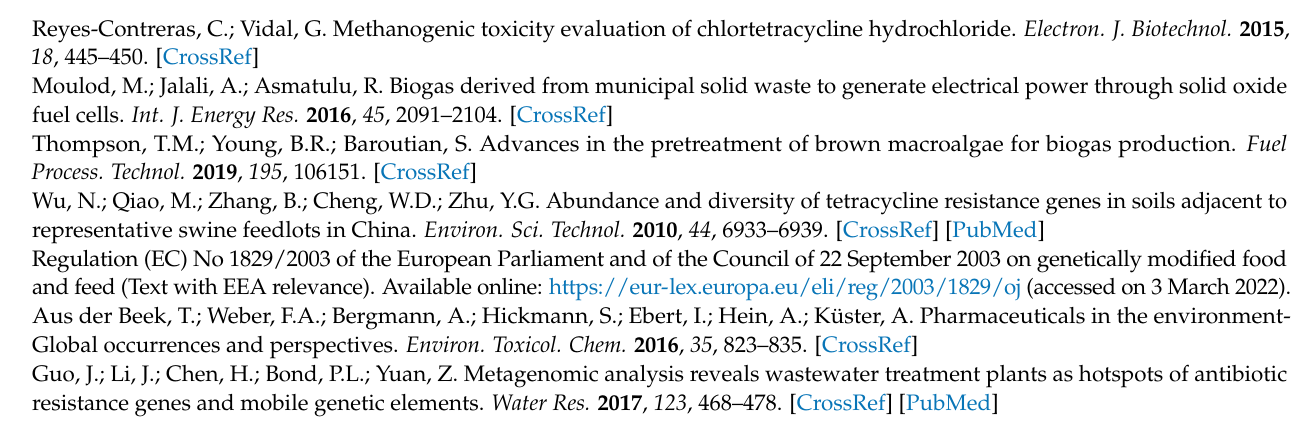
Table S3: Correlations between microbial counts a and concentrations of antibiotic resistance genes